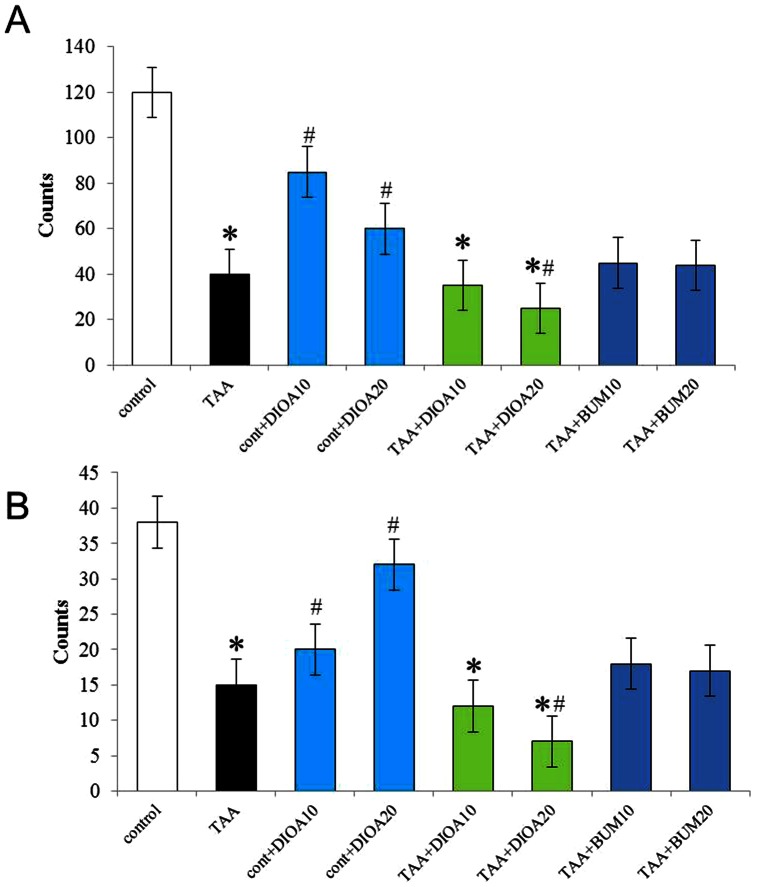
Effect of intranigral blockage of KCC2 or NKCC1 on the motor activities in GAD67 - GFP knock - in mice of each group, evaluated by open field test.Horizontal (A) and vertical (B) locomotor activity was measured. TAA induced significant hypolocomotion. Blockage of KCC2 by intranigral injection of DIOA (a KCC2 blocker) at two concentrations (10 and 20 µg/0.5 µl) induced motor function impairment in both horizontal and vertical activities in the normal mice (cont+DIOA10 and cont+DIOA20), and higher concentration of DIOA (20 µg/0.5 µl) had much more remarkable motor impairment. In addition, blockage of KCC2 by intranigral injection of DIOA (with higher concentration, 20 µg/0.5 µl) deteriorated hypolocomotion in both horizontal and vertical activities in TAA mice (TAA+DIOA20), although a lower concentration of DIOA (10 µg/0.5 µl) had no such effect (TAA+DIOA10) on TAA-induced hypolocomotion. Blockage of NKCC1 by intranigral injection of bumetanide (BUM) (a selective inhibitor of NKCC1) with two concentrations (10 and 20 nmol/0.5 µl) had no effect on TAA-induced hypolocomotion in both horizontal and vertical activities (TAA+BUM10 and TAA+BUM20). * P<0.05 vs. control and # P<0.05 vs TAA - treated mice.